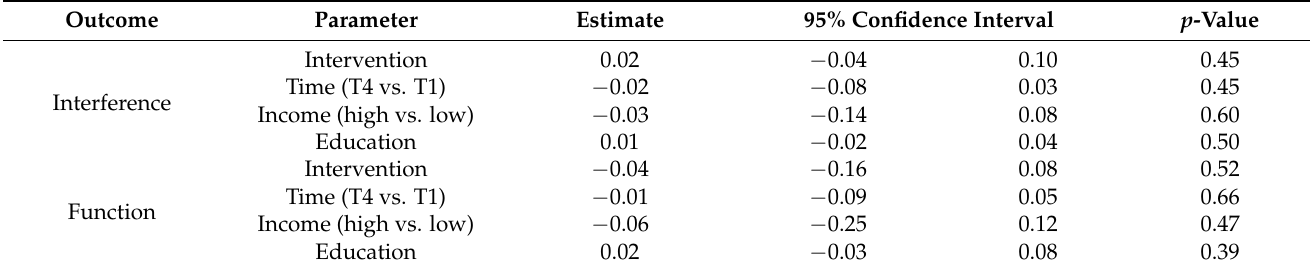
Table 3. Multivariate analyses of the predictors of oral-health-related quality of life outcomes. Outcome